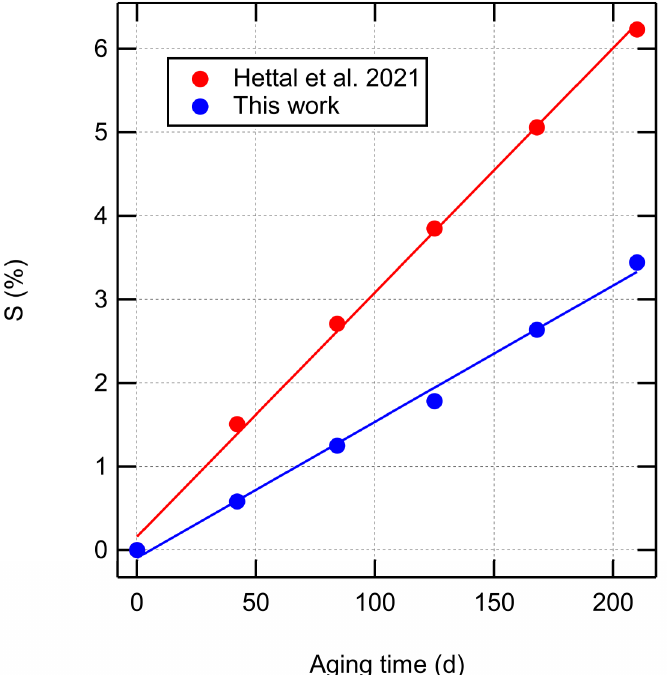
Figure 6. Fraction of scissed bonds as a function of aging time from Table 1 compared to the predic- tion of an analytical aging model